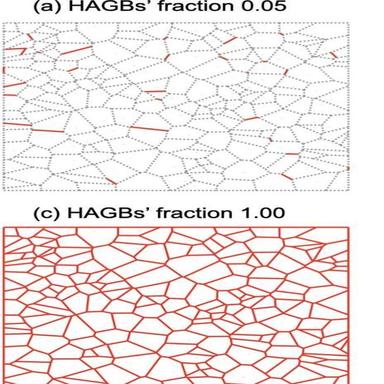
Illustration of possible microstructure configurations: (a) no grains, all polygons are cells; (b) grains and cells coexist; (c) no cells, all polygons are grains.